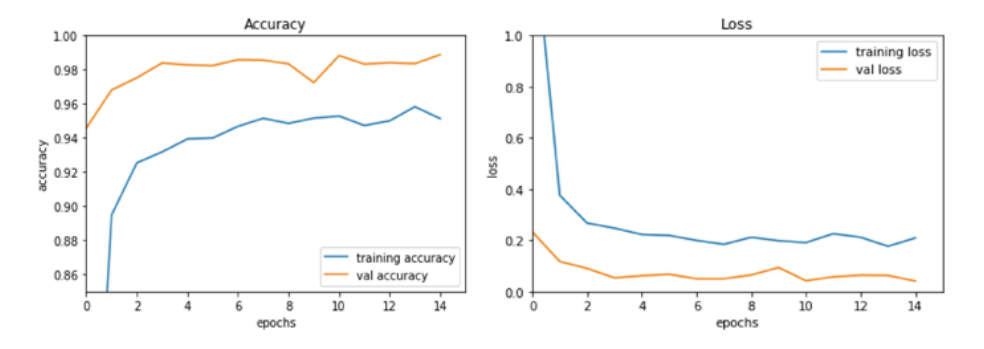
Fig. 16. Accuracy and loss for coloured images. Accuracy and loss obtained from normalized images as shown in Figure 17 & Loss:0.0892,